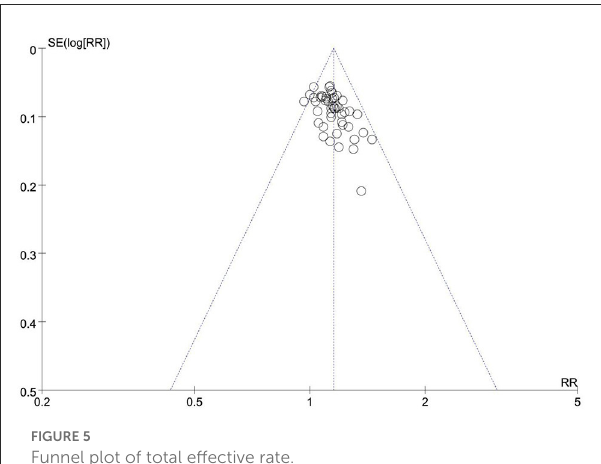
FIGURE5 Funnel plot of total effective